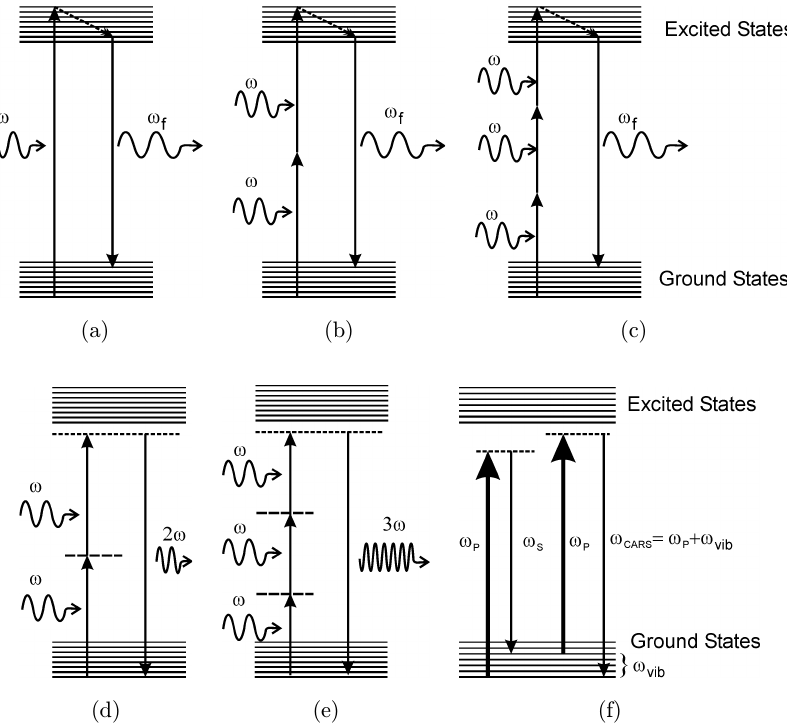
Fig. 3. Fluorescence emission by: (a) single-photon excitation (b) two-photon excitation and three-photon excitation. Fluorescence is characterized by nonresonant processes resulting in incoherent emission. The coherent scattering processes are shown by resonant emission from (d) two-photon absorption as in SHG, (e) three photon-absorption as in THG and (f)